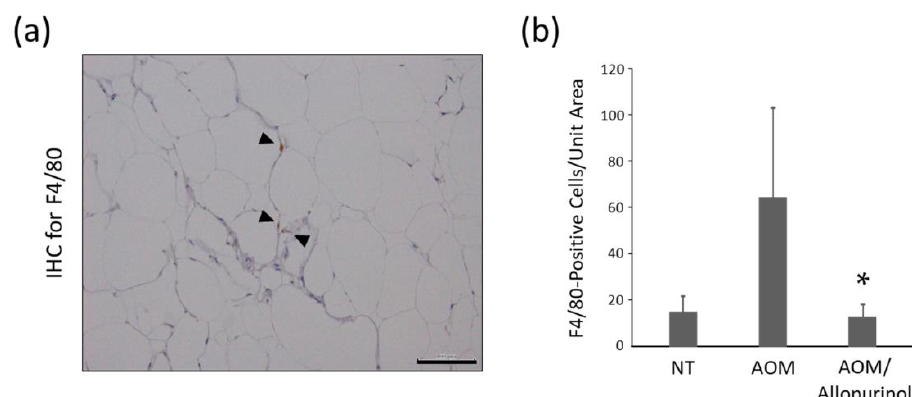
Figure 3. Effect of allopurinol treatment on macrophage infiltration in the adipose tissue of the experimental mice. ( a ) A representative picture of immunohistochemical staining for F4/80 in the adipose tissue of the experimental mice. F4/80‑stained cells are indicated by arrow heads. Scale bar, 100 µm. ( b ) The number of F4/80-positive cells per unit area was counted. The values are expressed as